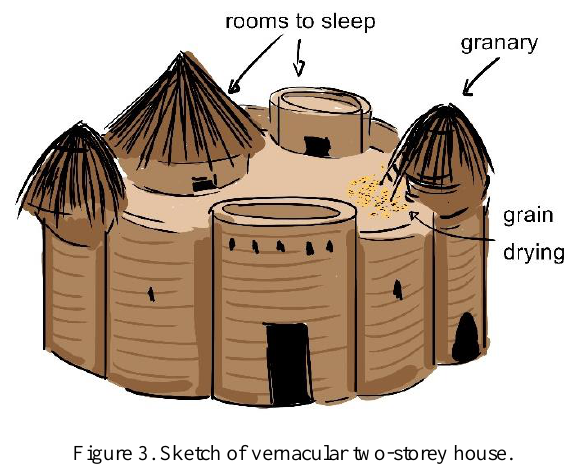
Figure 3. Sketch of vernacular two-storey house.